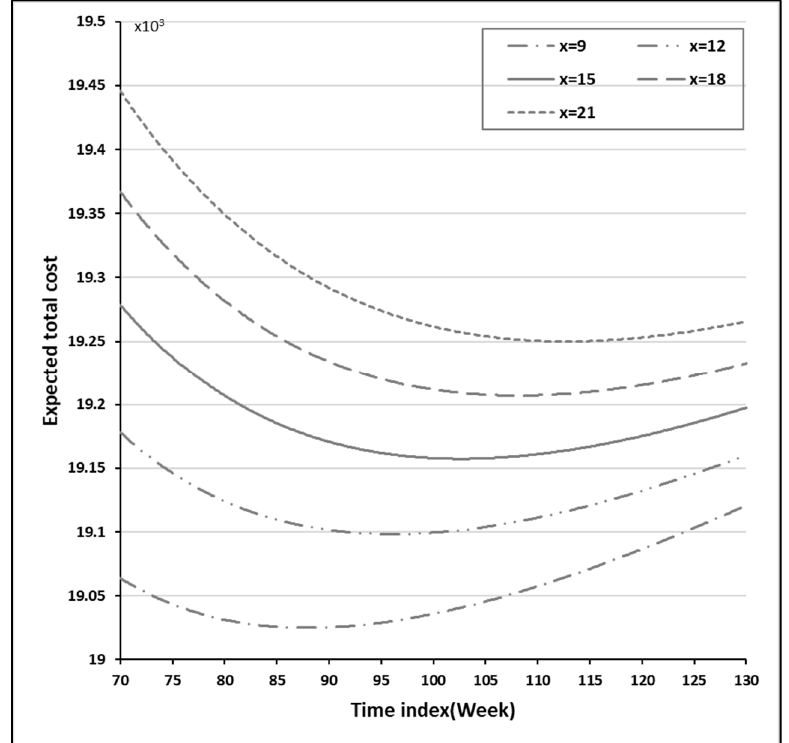
Figure 15. Expected total cost for the baseline case. Table 10. Optimal release time with expected total cost and the software reliability according to cost coefficient.